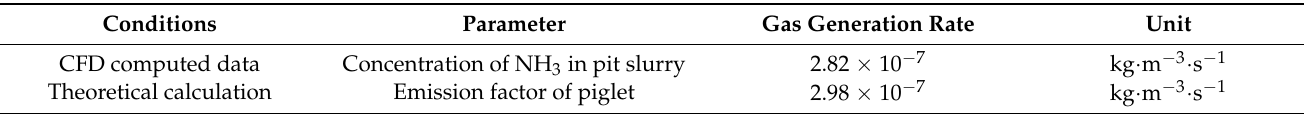
Table 5. Ammonia generation rate of CFD computed results and emission factor of domestic standard.